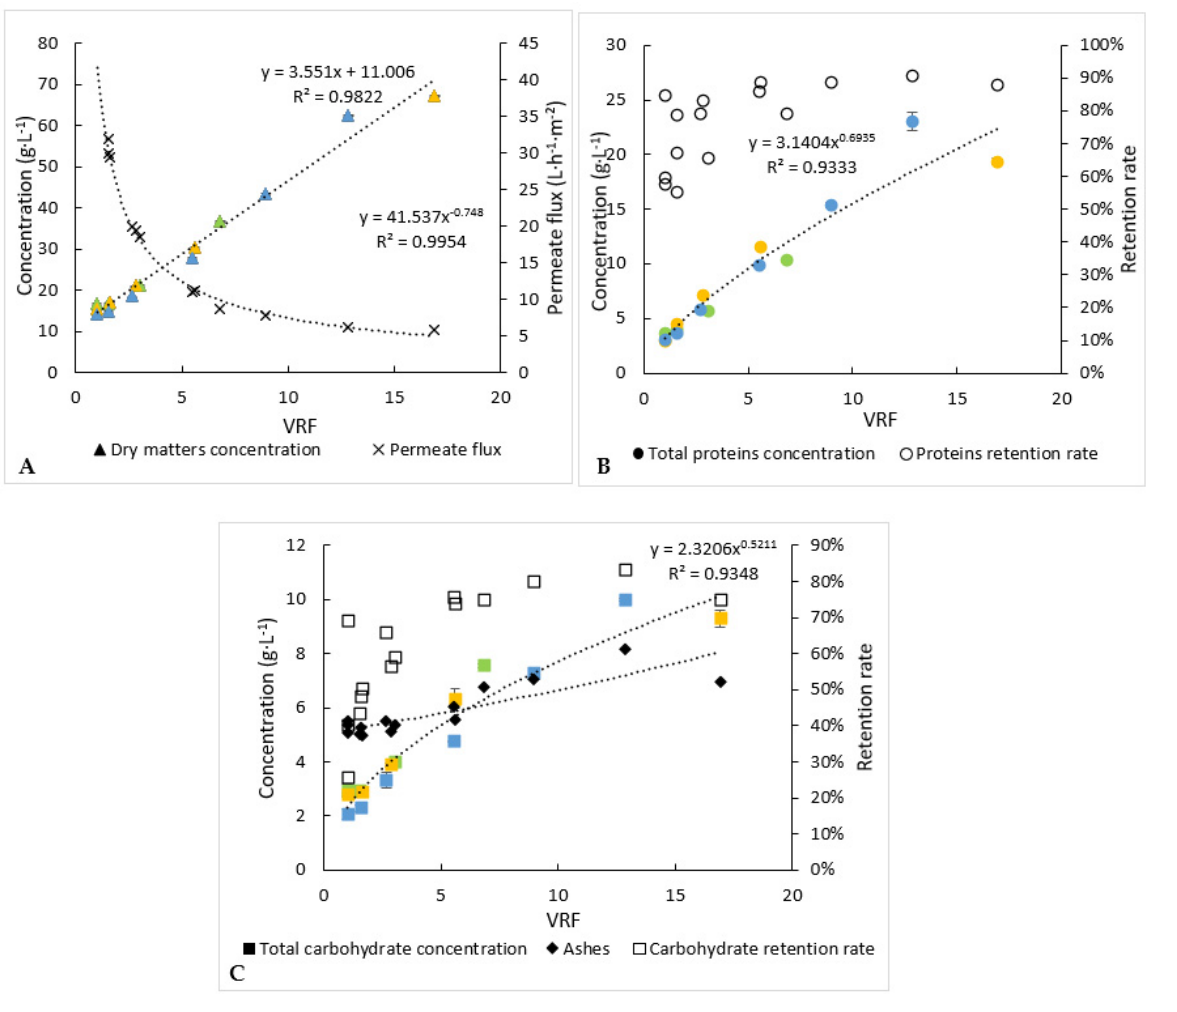
Figure 4. Biochemical follow-up of retentate during the 3 microfiltration experiments (each experiment is represented by one colour). ( A ) Dry-matter concentration and permeate flux, ( B ) analysis of proteins and ( C ) analysis of carbohydrates. Error bars correspond to the standard variations between 3 replicates for proteins and 2 replicates for carbohydrates and dry matter.